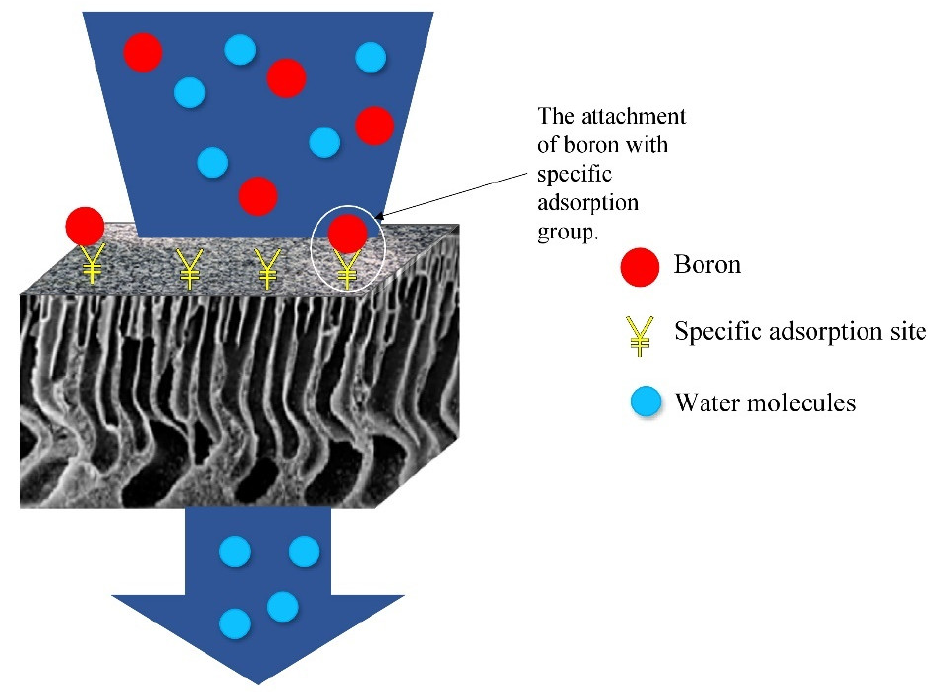
Figure 6. Overall illustration about capturing boron using an adsorptive membrane.